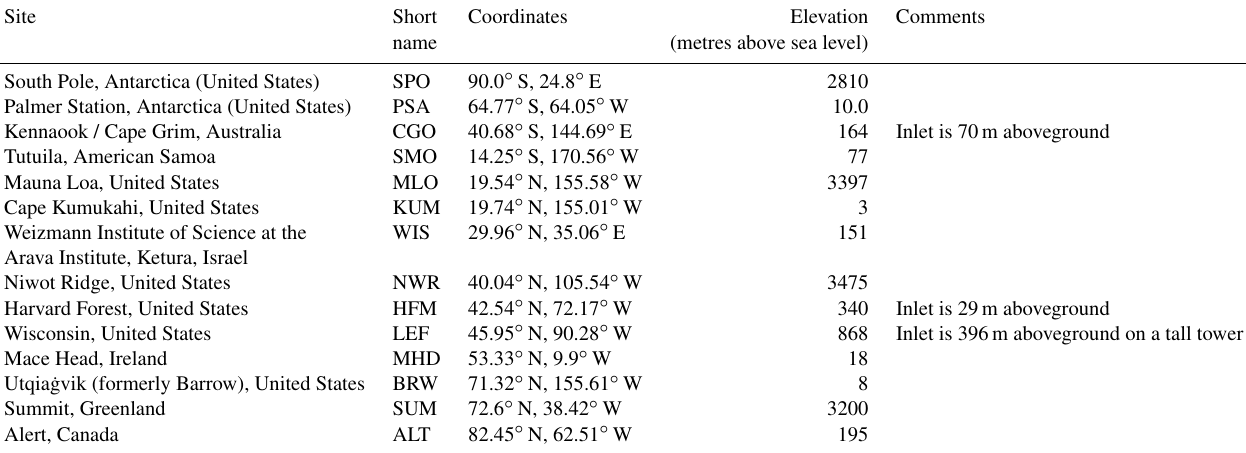
Table B1. List of air sampling sites selected for evaluation of COS concentrations.